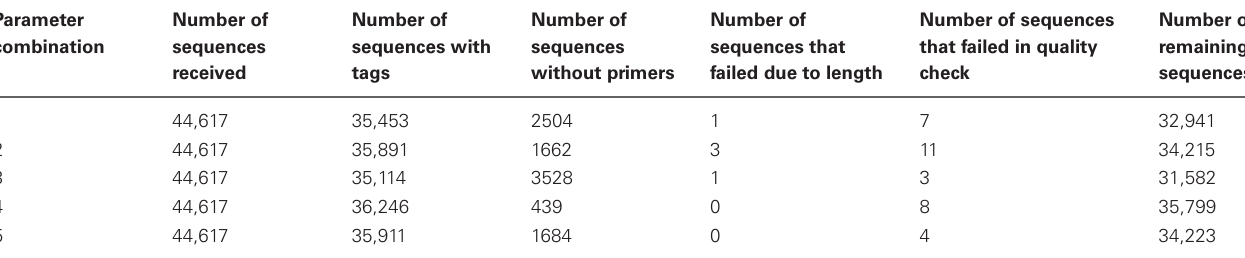
Table 2 | A summary of the Ig-HTS-Cleaner results in each parameter combination: human data set of 44K sequences.